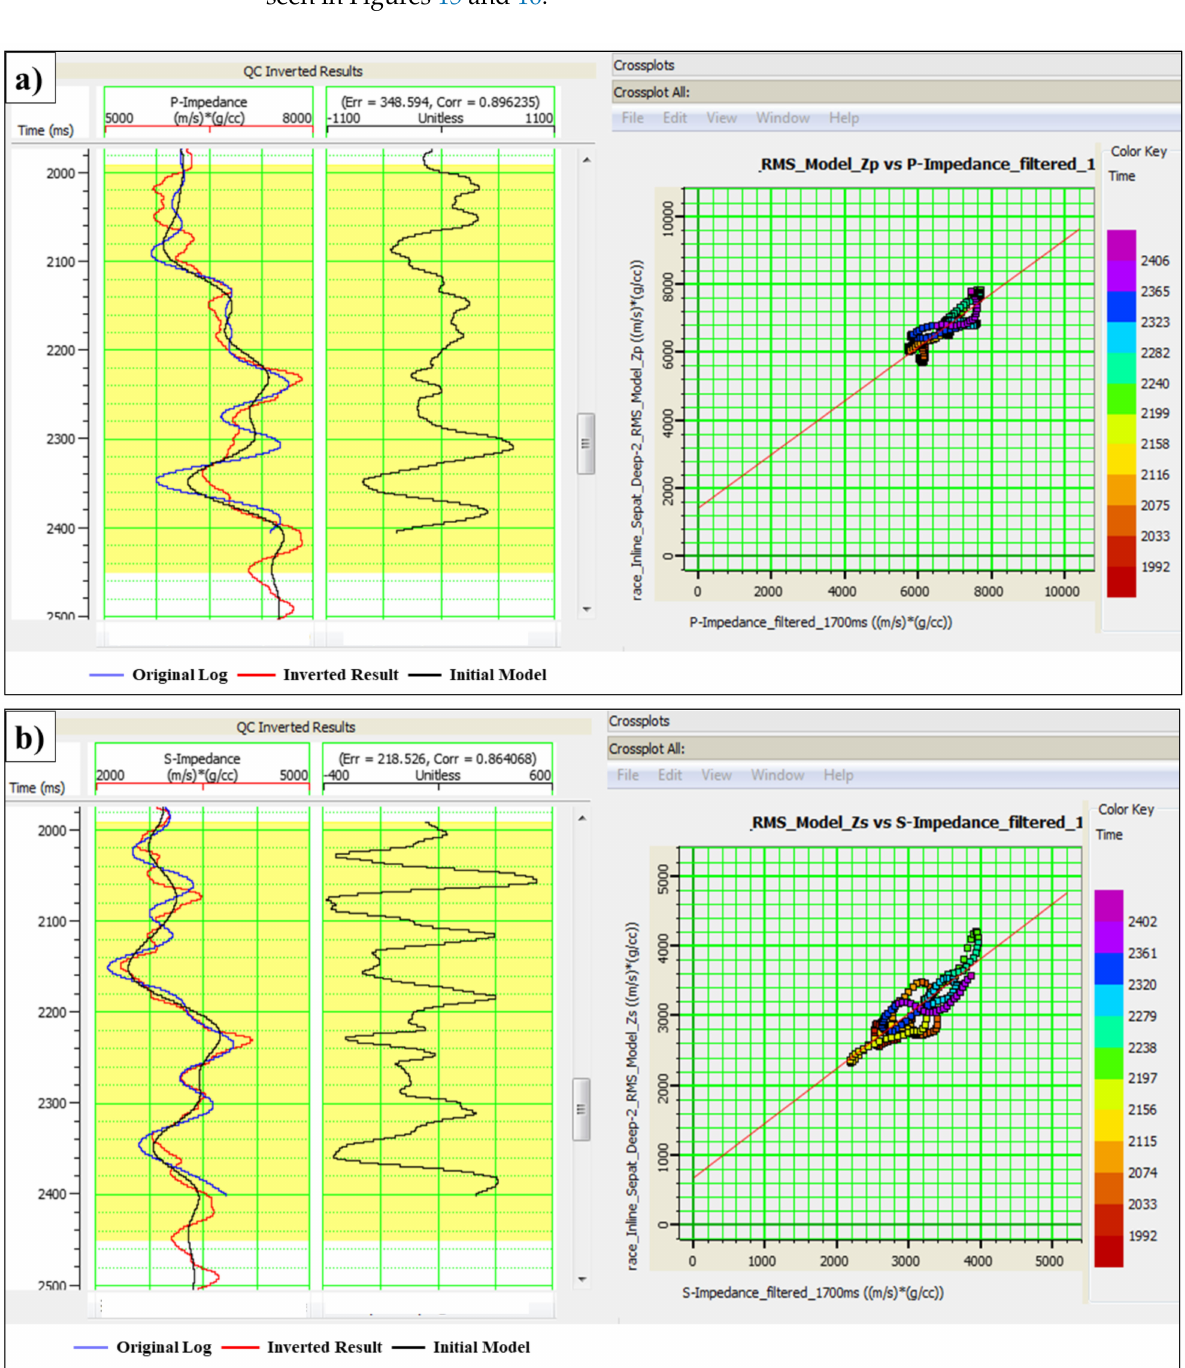
Figure 15. ( a ) Simultaneous pre-stack inversion analysis plot for P-impedance property for well XD-2 within error calculation time window (yellow colour). The correlation between the original (blue) and inverted (red) P-impedance logs is 0.89. ( b ) Simultaneous pre-stack inversion analysis plot for S-impedance property for well XD-2 within error calculation time window (yellow colour). The correlation between the original (blue) and inverted (red) SI logs is